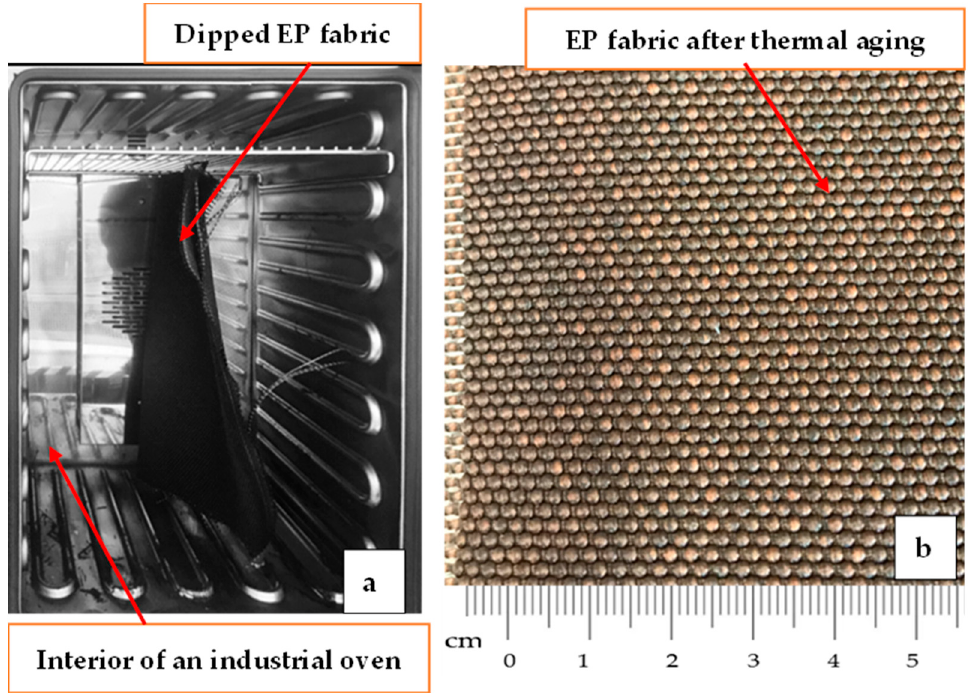
Figure 4. ( a ) An industrial oven for a thermal aging of fabric; ( b ) EP fabric sample aged at 220 °C for 6 min.